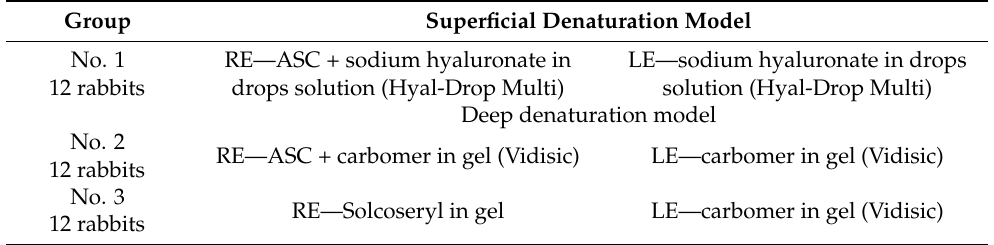
Table 1. Diagram of the experiment. RE—right eye, LE—left eye, ASC—antler stem cells, Lacrimal (sodium hyaluronate in commercial preparation), Vidisic (carbomer in commercial preparation), Solcoseryl (commercial